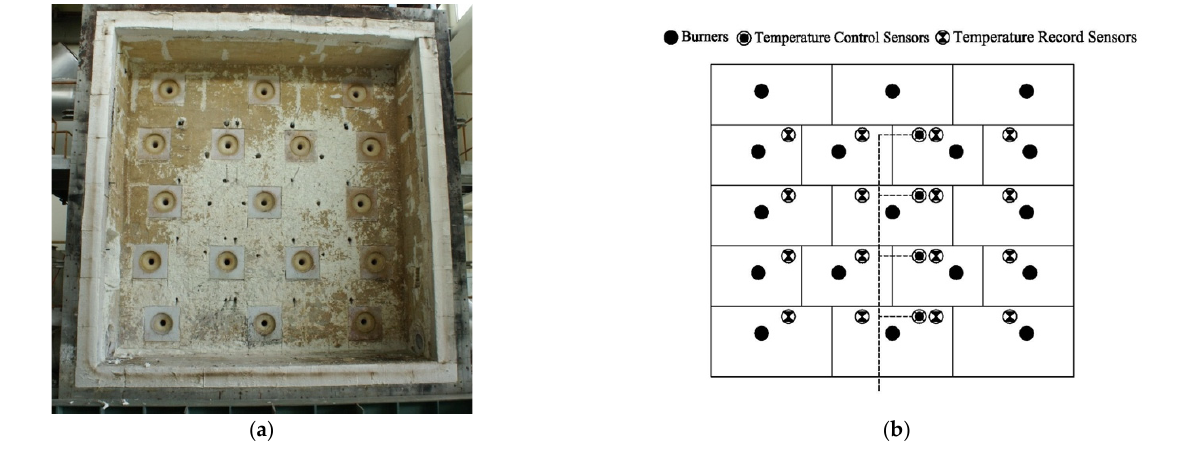
Figure 1. ( a ) Full-scale door/wall refractory furnace; ( b ) positions of thermocouples inside the furnace.